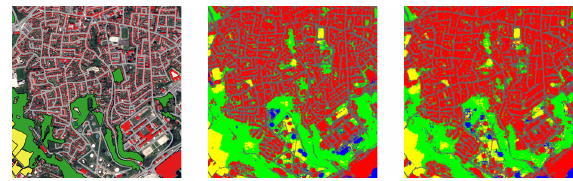
Figure 3. Comparison of 3-l (middle) and 4-l nets (right): the reference data is on the left.